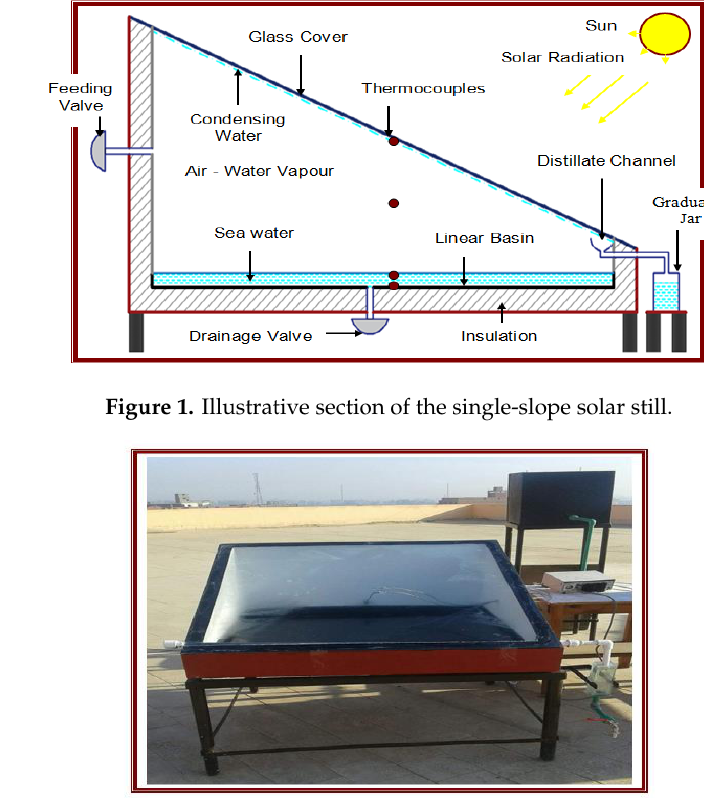
Figure 2. A photograph of the single-slope solar still.